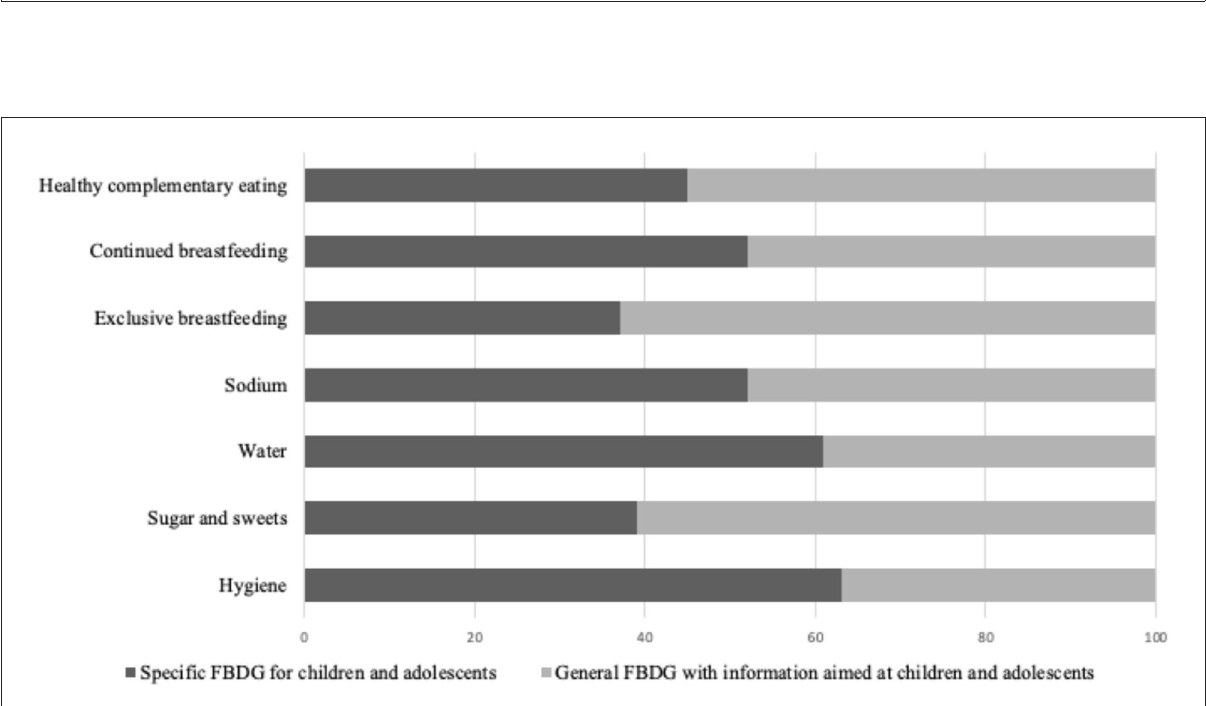
FIGURE6 Percentage distribution of FBDGs with specific nutritional recommendations according to the type of